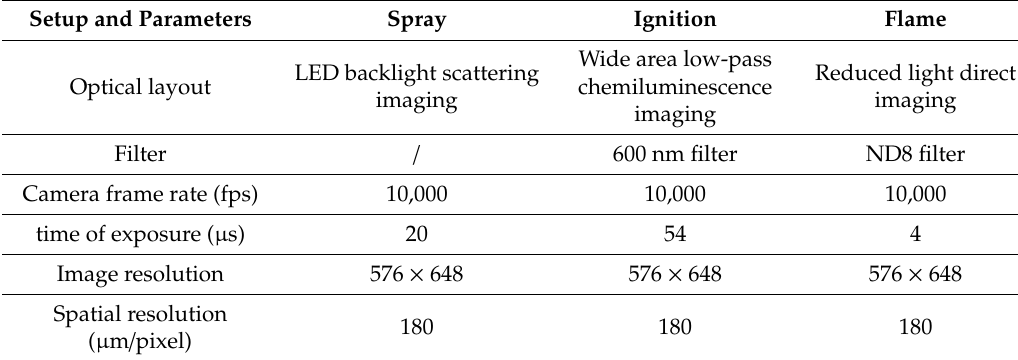
Table 1. Imaging conditions.